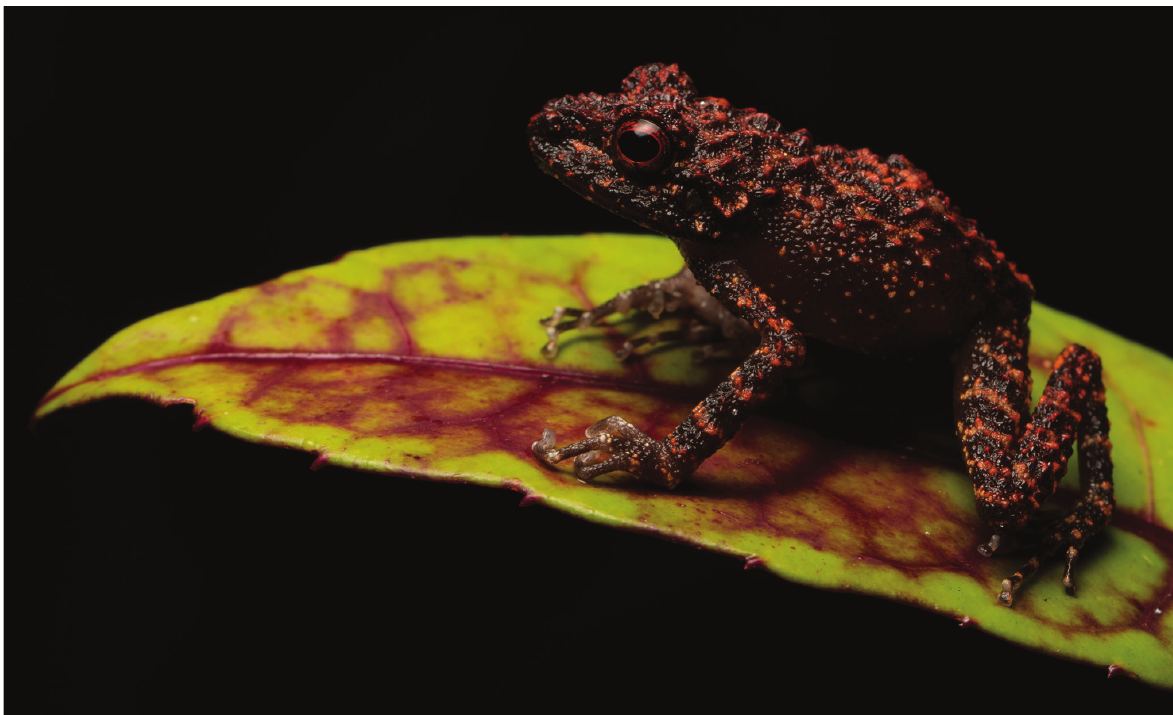
Figure 7. In-situ photograph of Gephyromantis marokoroko sp. nov.